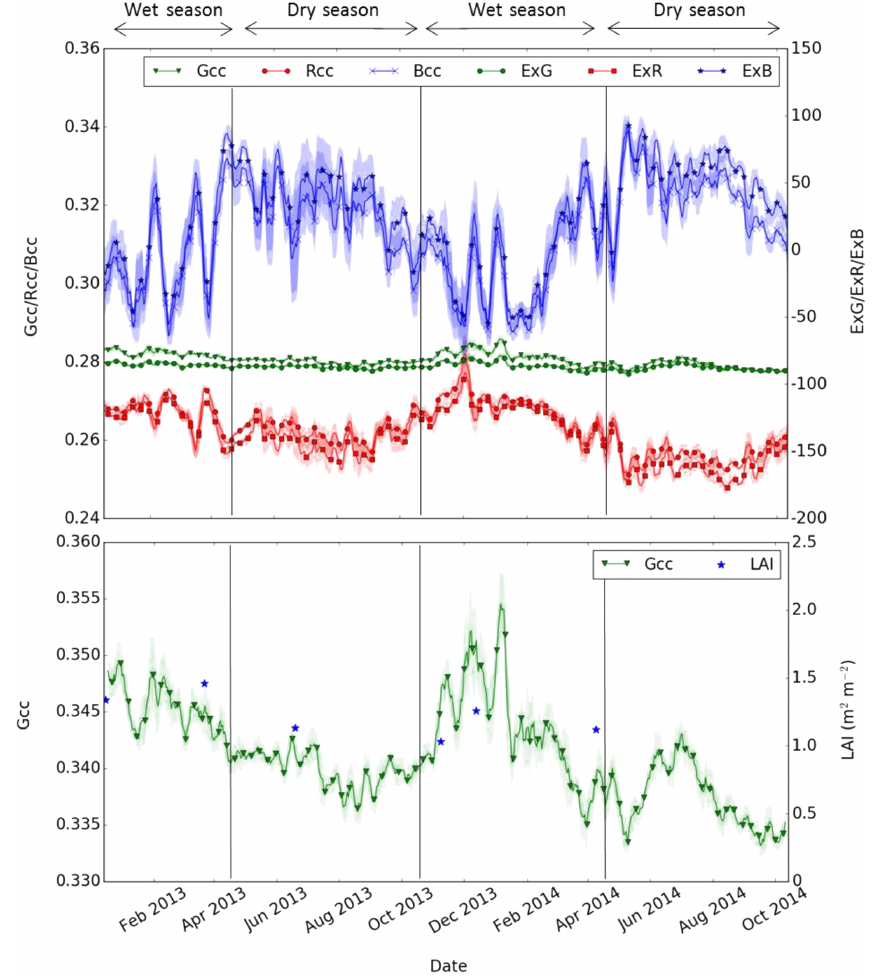
Figure 6. Daily green, red and blue chromatic coordinates (GCC–RCC–BCC) and excess indices (ExG–ExR–ExB) for the Howard Springs OzFlux site overstory (a) , plus GCC and leaf area index (LAI) for the overstory (b) from December 2012 to October 2014. Daily data are shown with an 8-day centred running mean (marked every 8 days for visualisation) applied. The standard error of the mean is given by the